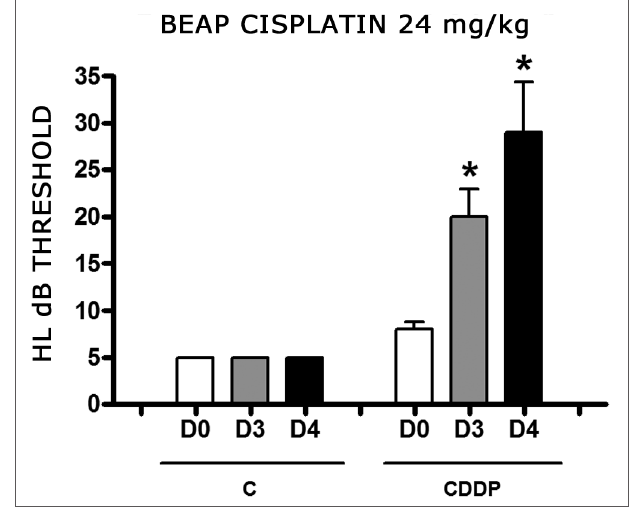
Figure 6. Graph showing the mean I-V interval of the animals in groups 9 and 10 at days D0, D3 and D4 expressed as mean and mean stan- dard error (MED and [IEY1] EPM). We did not find statistical difference between days in the two groups. ANOVA p >